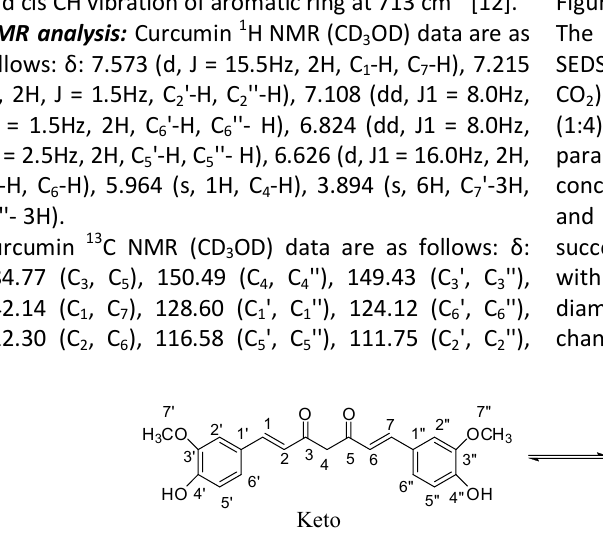
Fig. 3. The chemical structure of curcumin